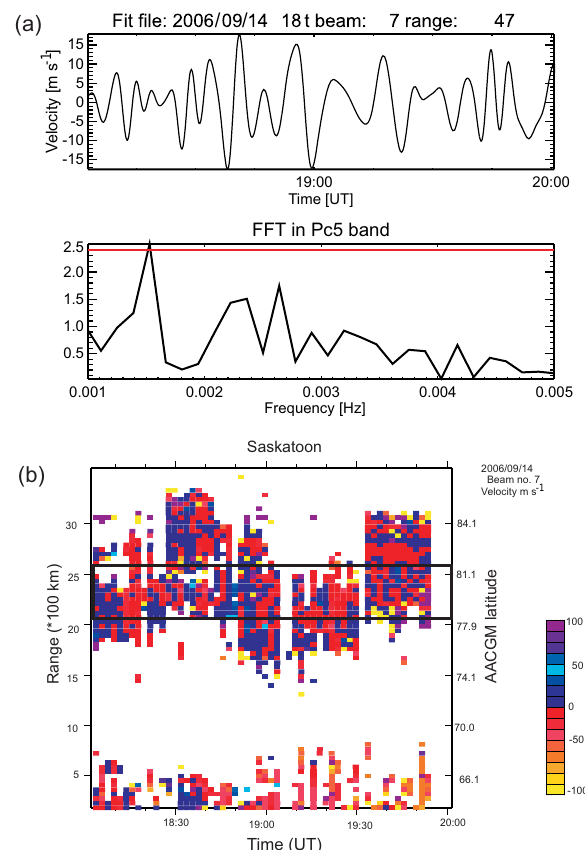
Figure 6. Event 3: (a) the top panel shows Pc5 band-filtered Doppler velocity data from the Saskatoon radar. The lower panel contains the corresponding power spectrum together with the sig- nificant limit level from filtered data. The peak detector recorded the peak in frequency band 1.4–1.7mHz as significant. (b) A time– range summary plot of Doppler velocity in metres per second mea- sured by beam 7 of Saskatoon radar showing range and AACGM latitude.